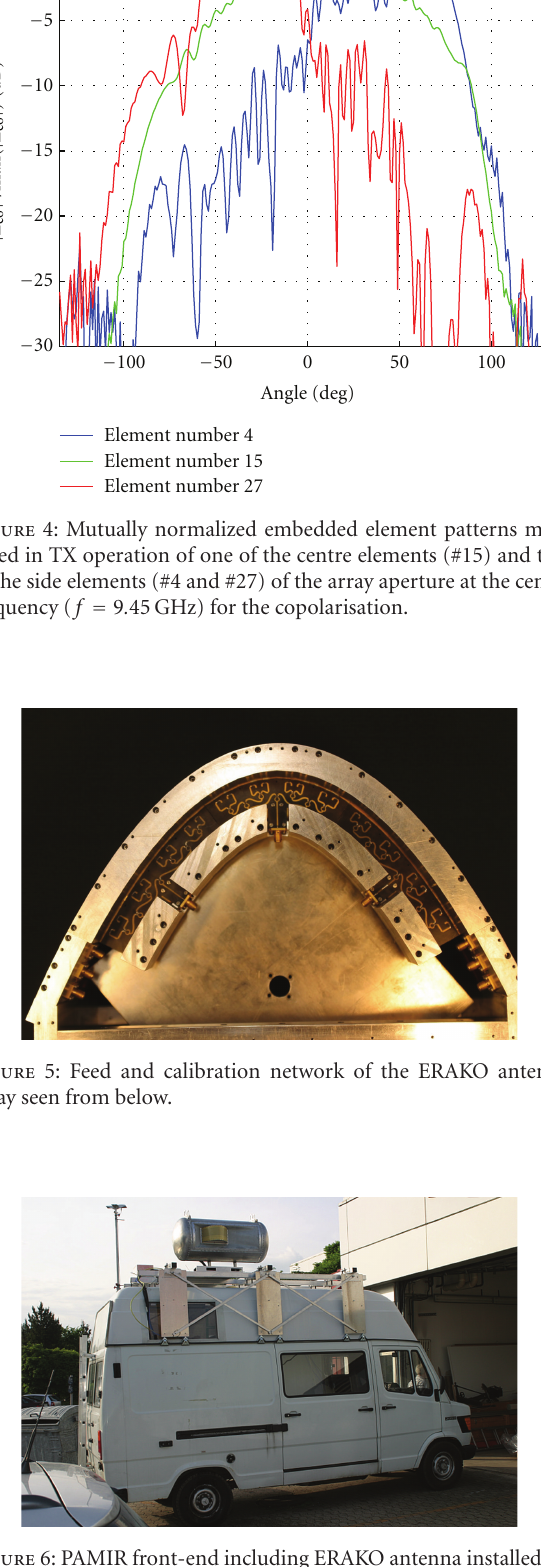
Figure 6: PAMIR front-end including ERAKO antenna installed on experimental